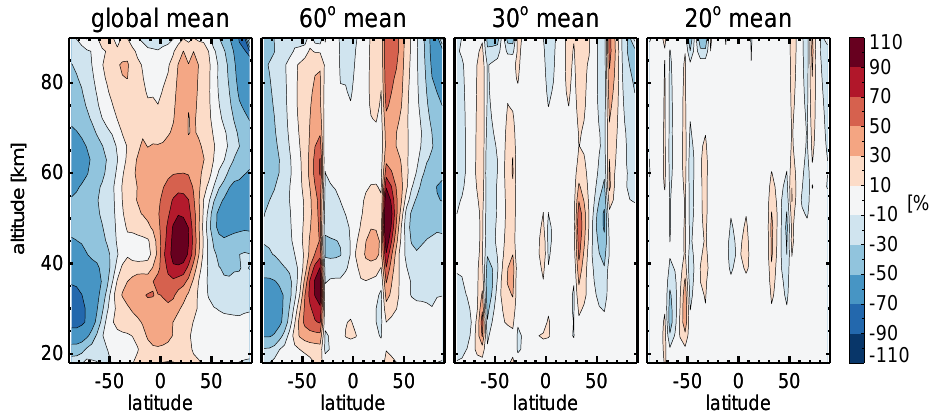
Fig. 8. CH 4 variation of global, 60 ◦ , 30 ◦ and 20 ◦ latitude bin profiles for the MIPAS MA mode days available in June, July and August for 2007, 2008 and 2009.